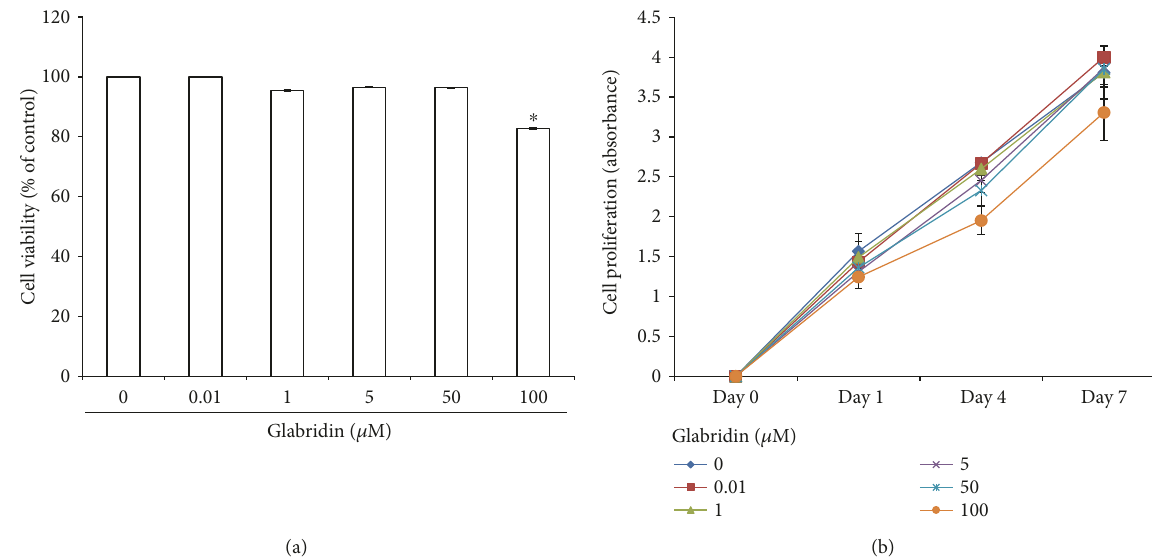
Figure 1: (a) E ff ect of glabridin on cell viability in bone marrow-derived mesenchymal stem cells (MSCs). Cell viability of MSCs treated with an increasing concentration of glabridin was determined by a CCK-8 assay. The data are expressed as the mean ± SD of three independent experiments. ∗ P < 0 05 versus untreated control. (b) Growth rates of cultured MSCs. Cells were cultivated with an increasing concentration of glabridin for 7 days. Proliferation activity was measured using a CCK-8 kit containing WST-8. The data are expressed as the mean ± SD of three independent